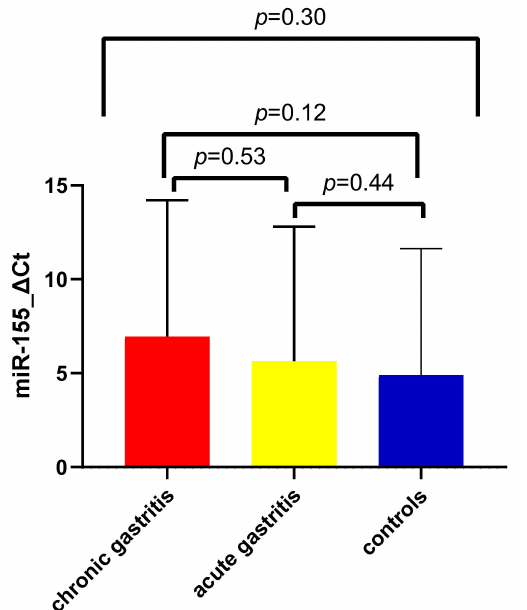
Figure 4. MiR-155 expression comparison between patients with acute gastritis, chronic gastritis, and control